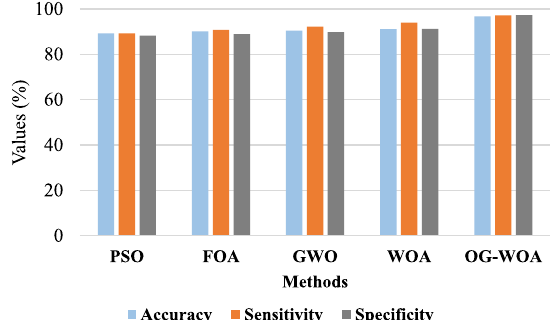
Fig. 12 Comparison of feature selection Methods on NWPU dataset